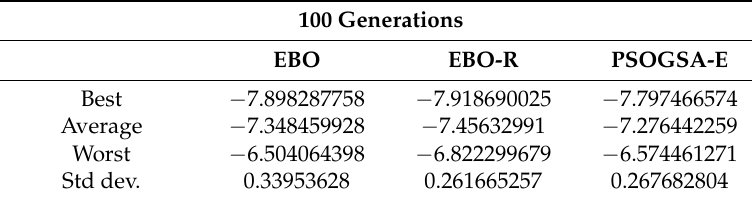
Table 3. Statistics for different algorithms (100 generations).